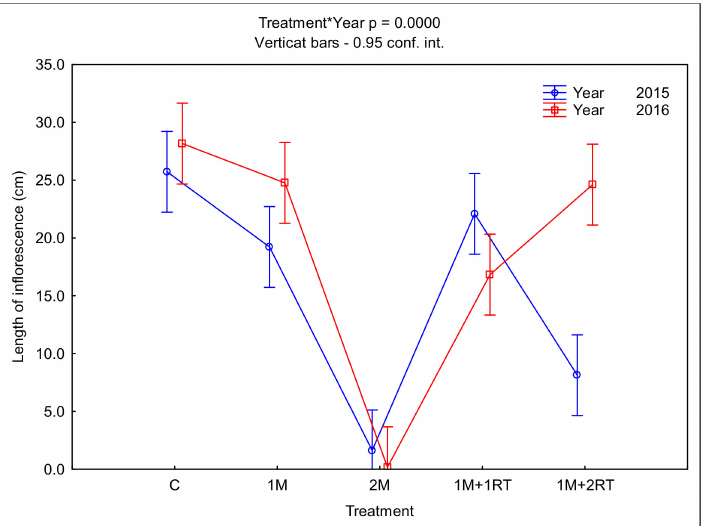
Figure 11. Mean length of goldenrod inflorescences, depending on the type of mechanical treat- ment. The following symbols denote the research treatments: C: control; 1M: one-time mowing; 2M: two-time mowing; 1M + 1RT: one-time mowing with one-time rotary tilling; 1M + 2RT: one-time mowing with two-times rotary